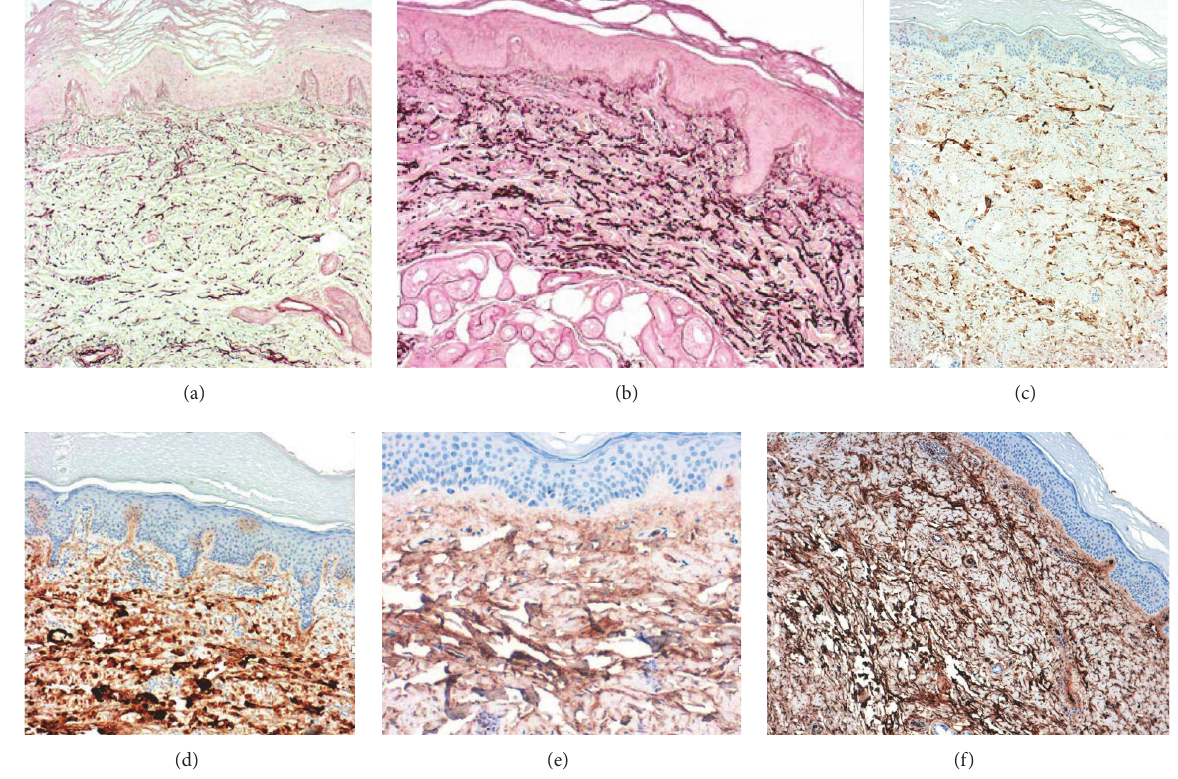
Figure 4: Immunohistochemical staining showing the significant increase of elastic fibers after the cosmetic treatment (b) compared to pretreatment (a). Immunohistochemical staining showing the expression of collagen III before (c) and after treatment showing a significant increaseofthisECMmarker(d).Immunohistochemicalstainingforfibronectinshowingitsexpressionbeforetreatment(e)andtheimportant increase after the cosmetic treatment (f) (40x